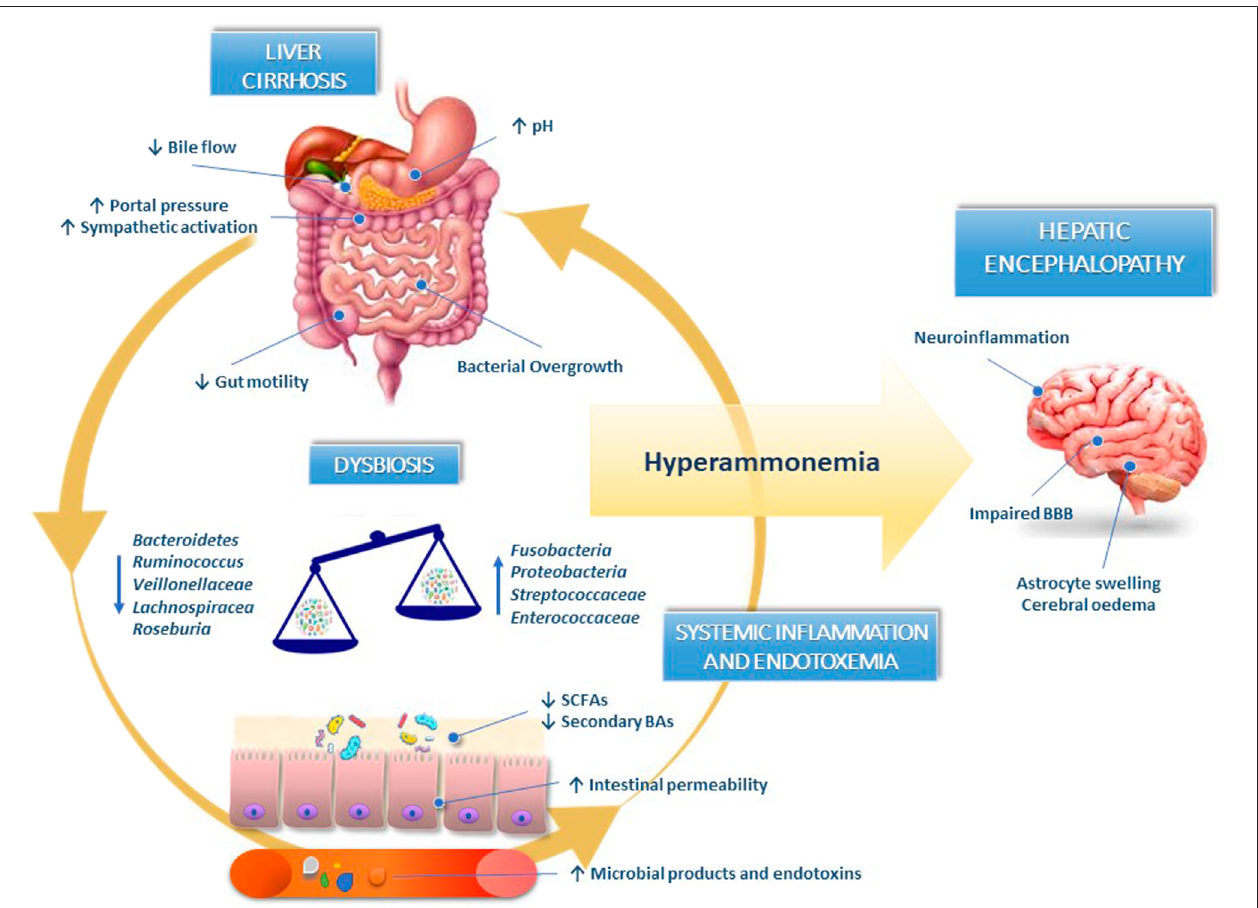
FIGURE 1 | Gut-liver-brain axis in the pathogenesis of hepatic encephalopathy. In liver cirrhosis, the decrease in bile acids synthesis, defective small intestinal motilityand reduced gastric acid secretion induce small intestinal bacterial overgrowth and dysbiosis.The reduced abundance ofbacteriasynthesising short-chain fatty